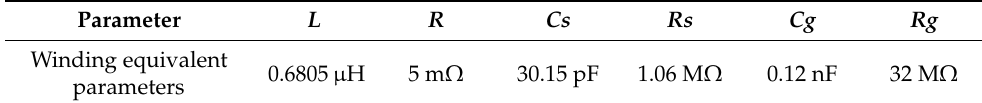
Table 4. Parameters of transformer winding equivalent